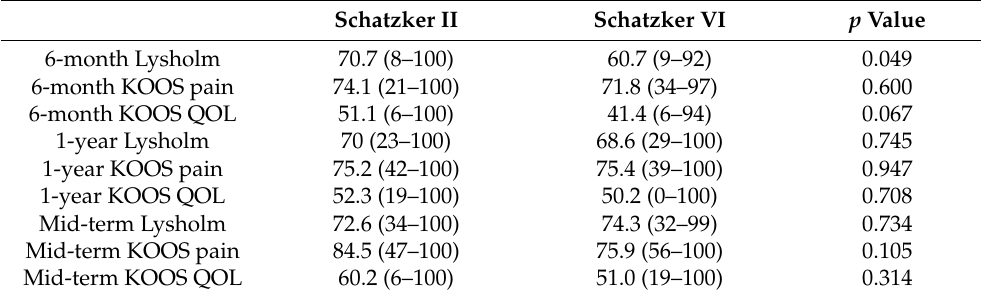
Table 5. Patient-reported outcomes scores vs. fracture type (Schatzker